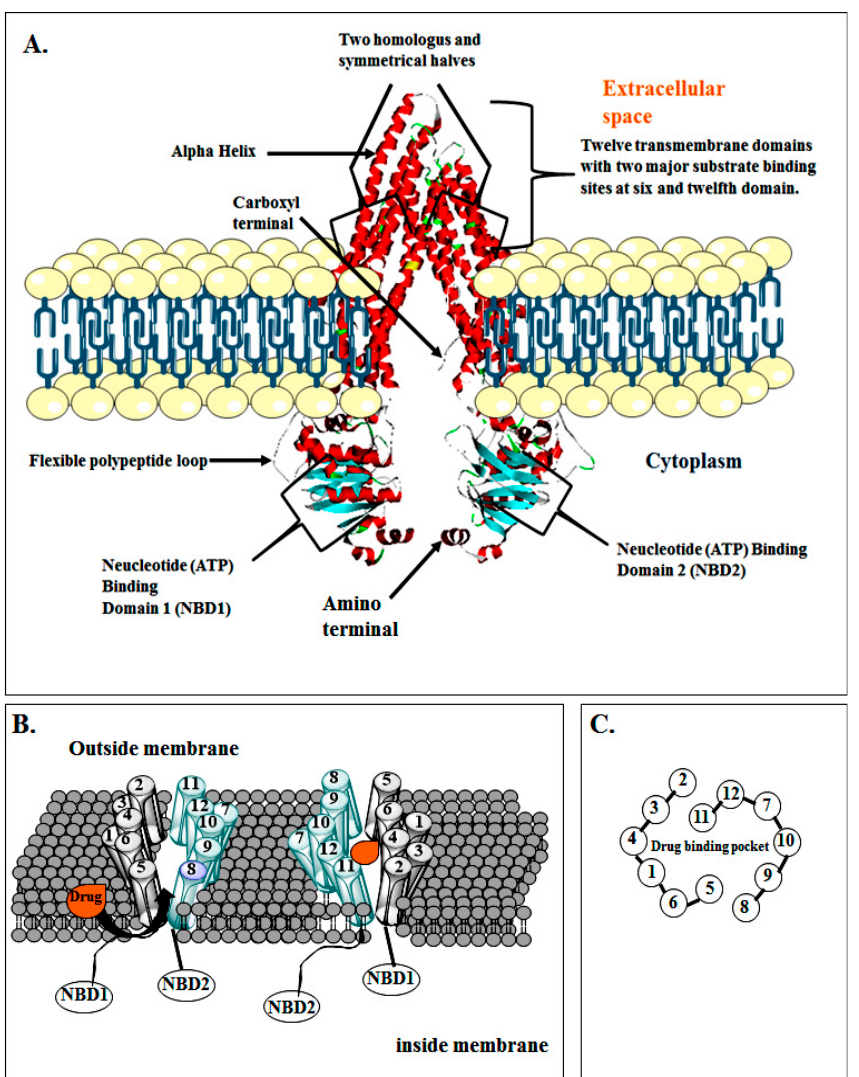
Figure 4. Schematic diagrams representing: ( A ) Structure of drug transporting P-gp; ( B ) drug binding pocket of P-gp; ( C ) drug binding pocket of P-gp surrounded by TMs [2,35–42].